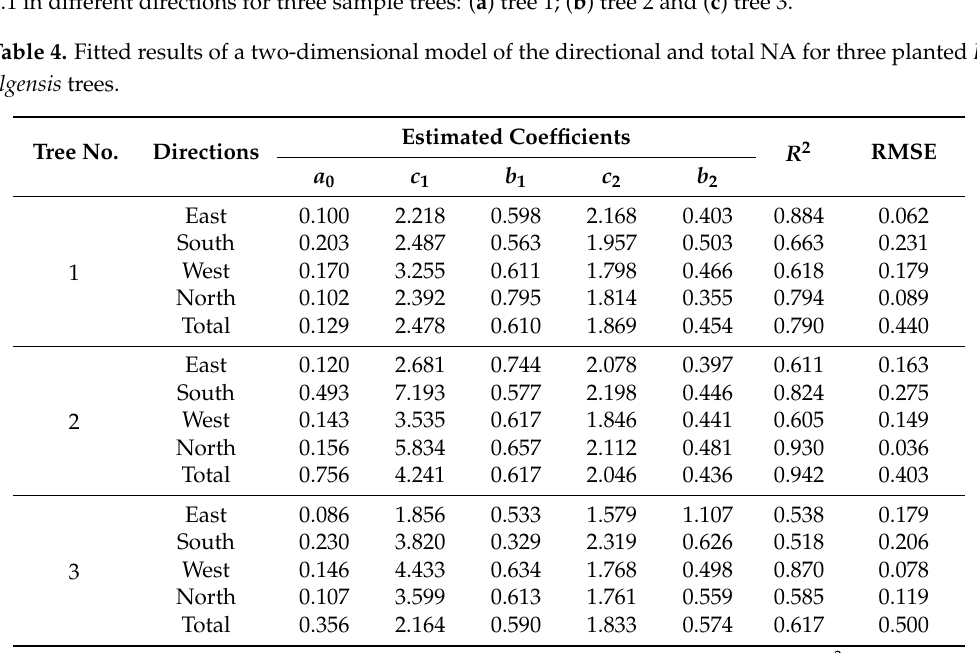
0.1 in different directions for three sample trees: ( a ) tree 1; ( b ) tree 2 and ( c ) tree 3.